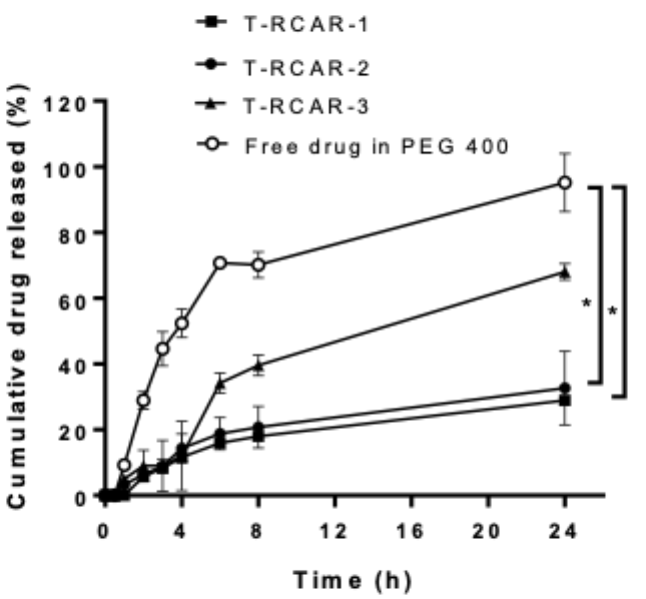
Figure 1. In vitro drug release profiles of free drug R-carvedilol dissolved in PEG 400 and three R-carvedilol-loaded transfersomes (T-RCARs). Formulations containing 100 µ g of R-carvedilol (concentration 40 ug/mL in 2.5 mL PBS) were loaded in the Pur-A-Lyzer Maxi Dialysis tube, which was immersed in 100 mL of PBS (pH 7.4) as the release medium. Three independent samples were set up for each formulation. At various time points, 1 mL of samples were withdrawn from the medium and replaced with 1 mL of fresh PBS. The samples were analyzed via HPLC. Data are presented as mean ± SEM (n = 3). *: p < 0.05 based on ordinary one-way ANOVA and Dunnett’s multiple comparisons test.